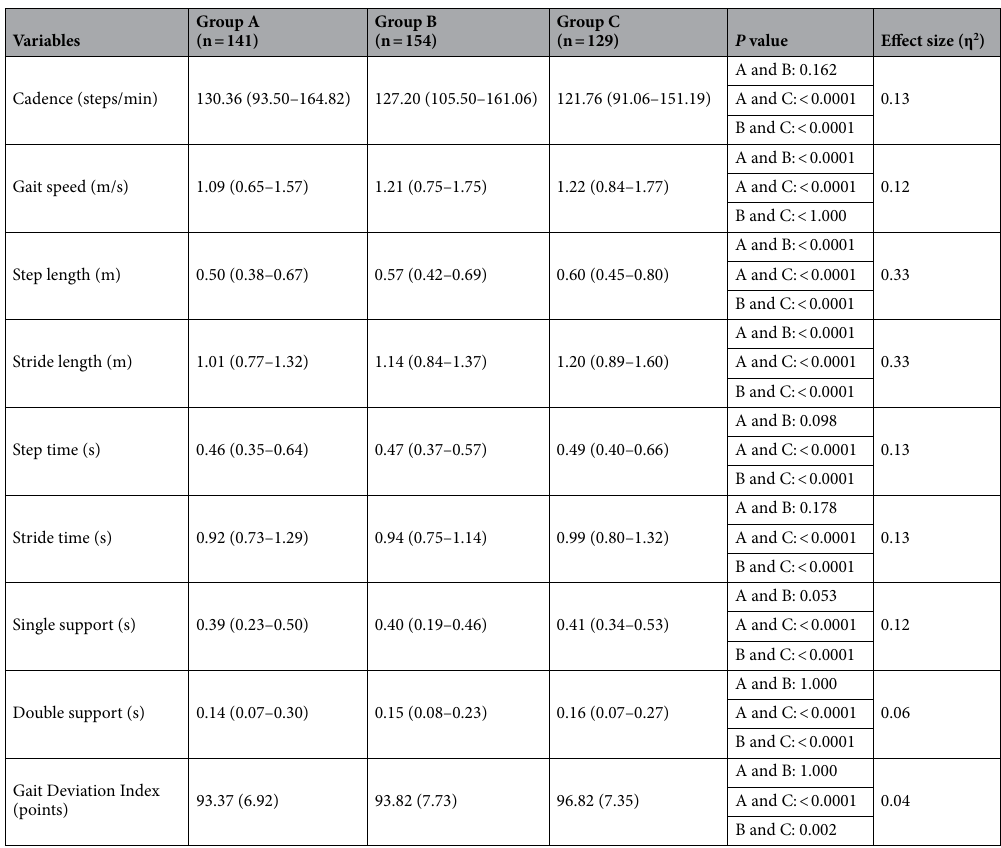
Table 2. Non-normalized spatiotemporal parameters and Gait Deviation Index for each age group (N = 424). Group A (6–8 years), Group B (9–10 years), Group C (11–12 years). Differences between the three groups were analyzed using the Kruskal–Wallis test or one-way analysis of variance. Variables with significant differences were subsequently compared using multiple comparison analyses with Bonferroni correction. Data are presented as means (standard deviation) or median values (range). P values < 0.0001 were considered statistically